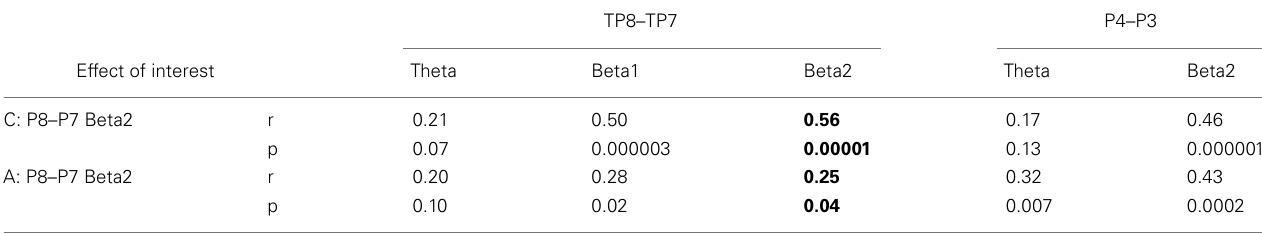
Table 6 | Correlations between the EoI and otherAIs that showed rightward asymmetry inADHD